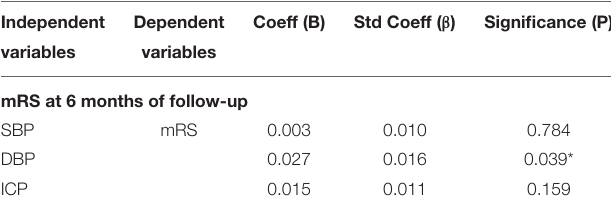
TABLE 3 | Neither SBP nor ICP was correlated with mRS at 6 months of follow-up.